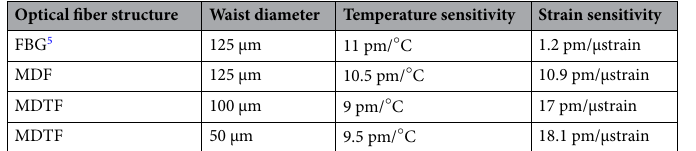
Table 2. Comparison of temperature and strain sensitivity for a FBG, micro-drilled fiber or micro-drilled tapered fiber.